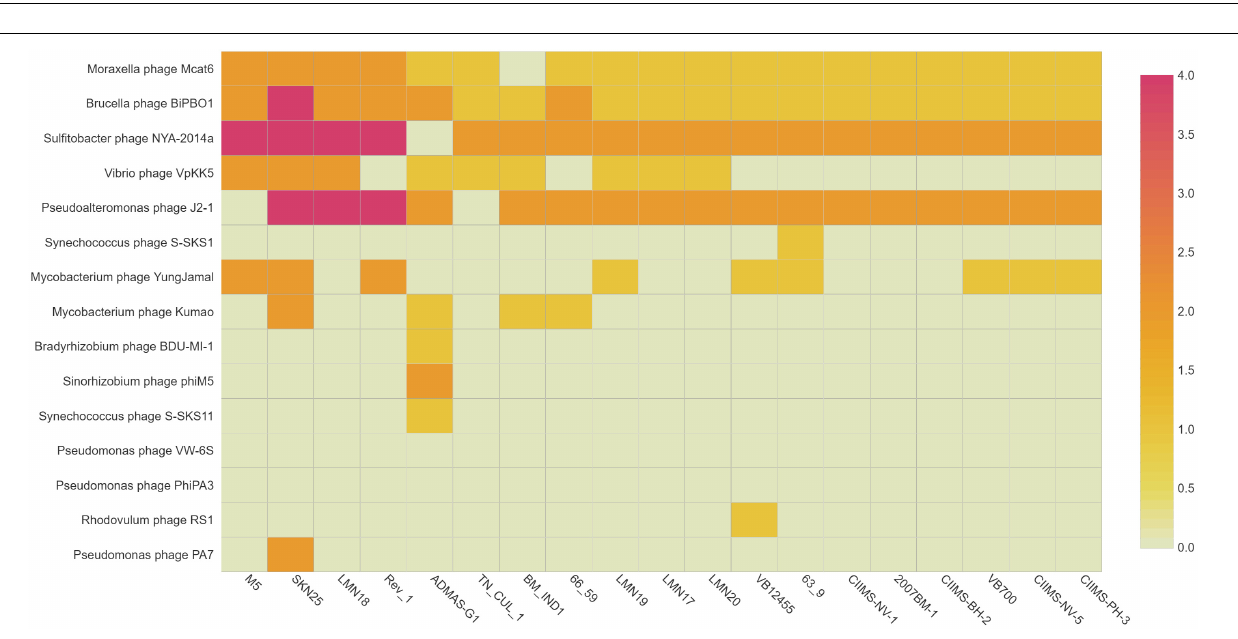
FIGURE 2 | Heatmap depicting the presence and absence of virulence genes. In the 2007BM-1 strain, genes ricA and wbkA are absent. Numbers in each cell represent the percentage similarity of the nucleotides of each virulence gene with the reference strain 16M.